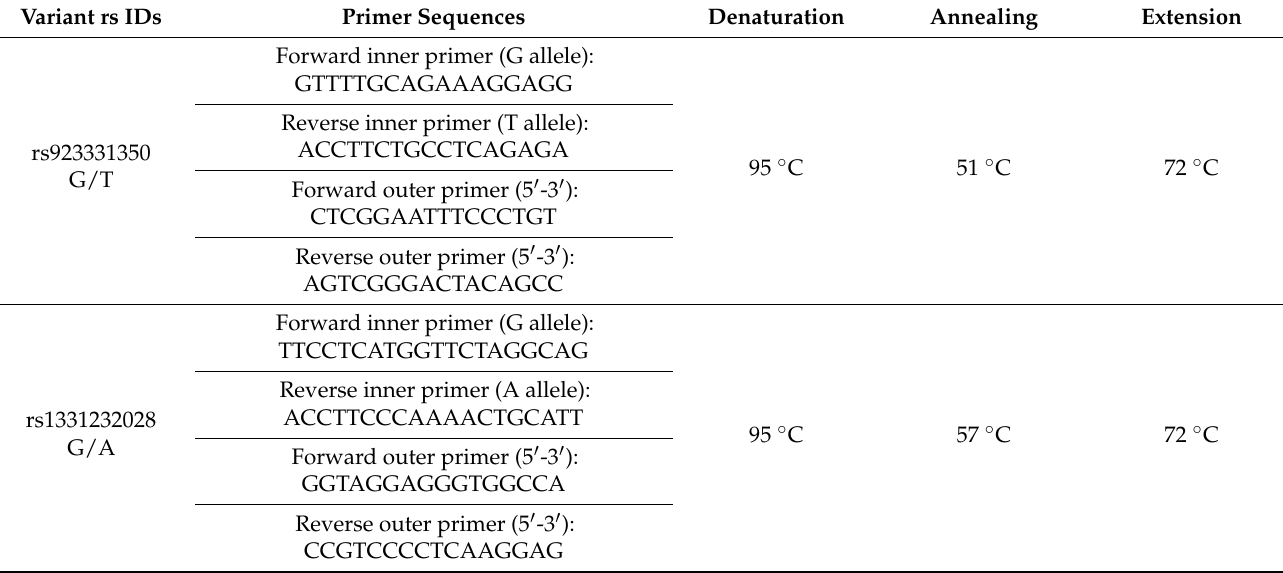
Table 1. Sequences of primers and PCR conditions used for genotyping of PKC γ variants rs923331350 and rs1331232028. Primer Sequences Denaturation